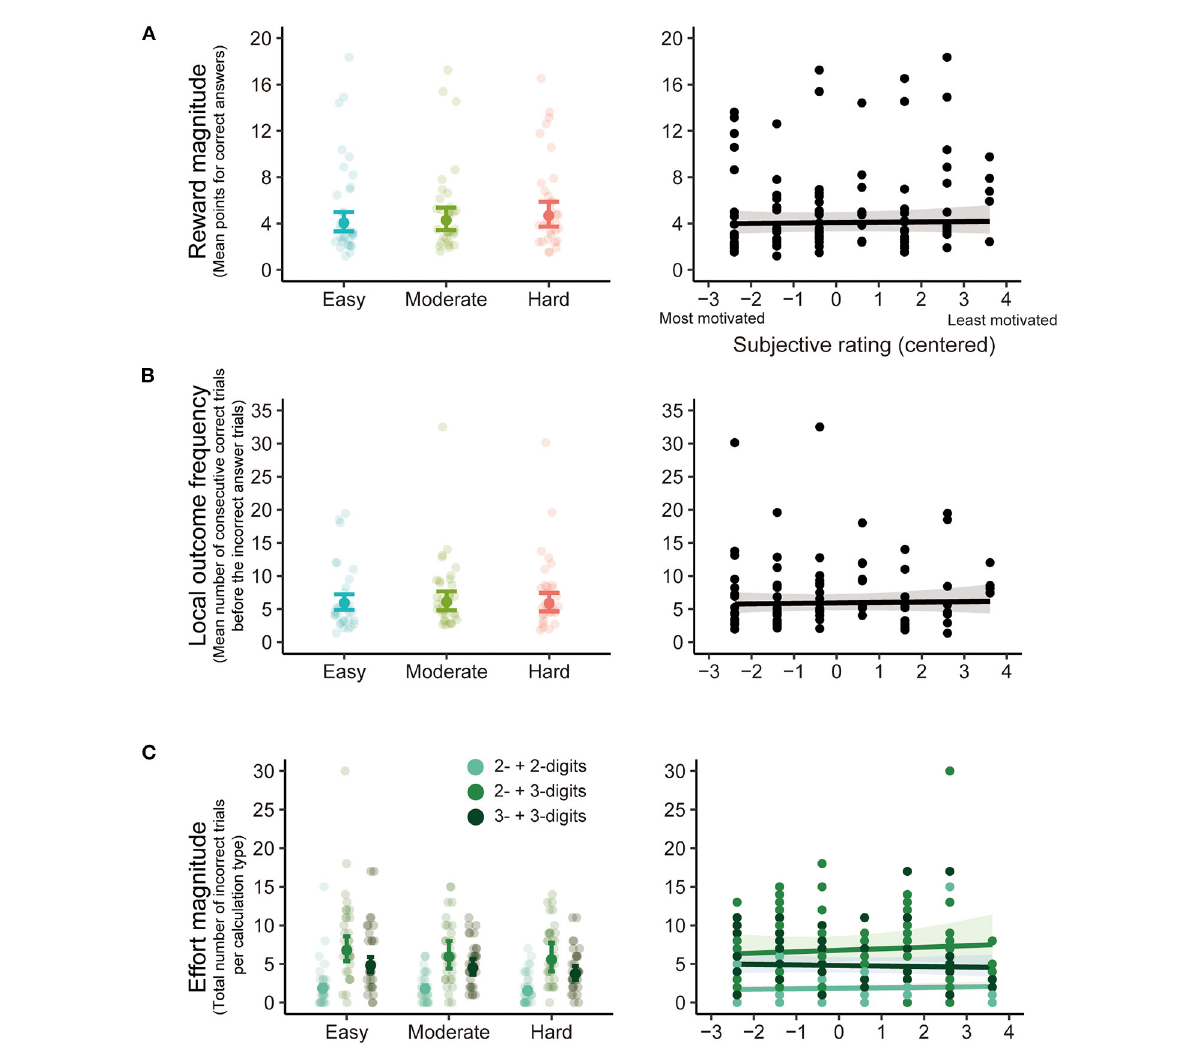
FIGURE6 The estimated coefficients of Goal (left) and the predicted values on Rating (right) in the (generalized) linear mixed-effects models [(G)LME] analyses for Reward magnitude (A) , Local outcome frequency (B) , and Effort magnitude (C) . In Goal results, the filled dots and error bars represent the estimated coefficients and 95% confidence intervals. The transparent dots are data points for each participant. In Rating results, the black line represents the predicted values from the (G)LME, and the gray area represents the 95% confidence interval. Black dots are data points for each participant (number of participants × number of levels of goal